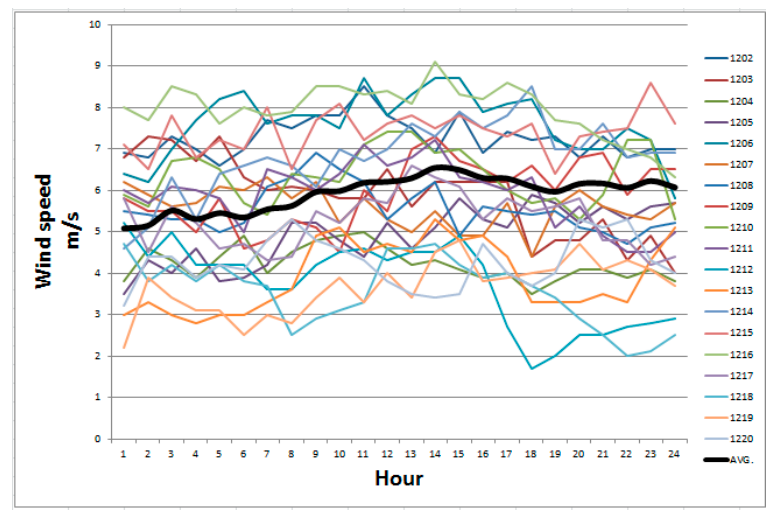
Figure 7. Wind speed scenarios of Chongtun/Huhs small wind turbines (WT).